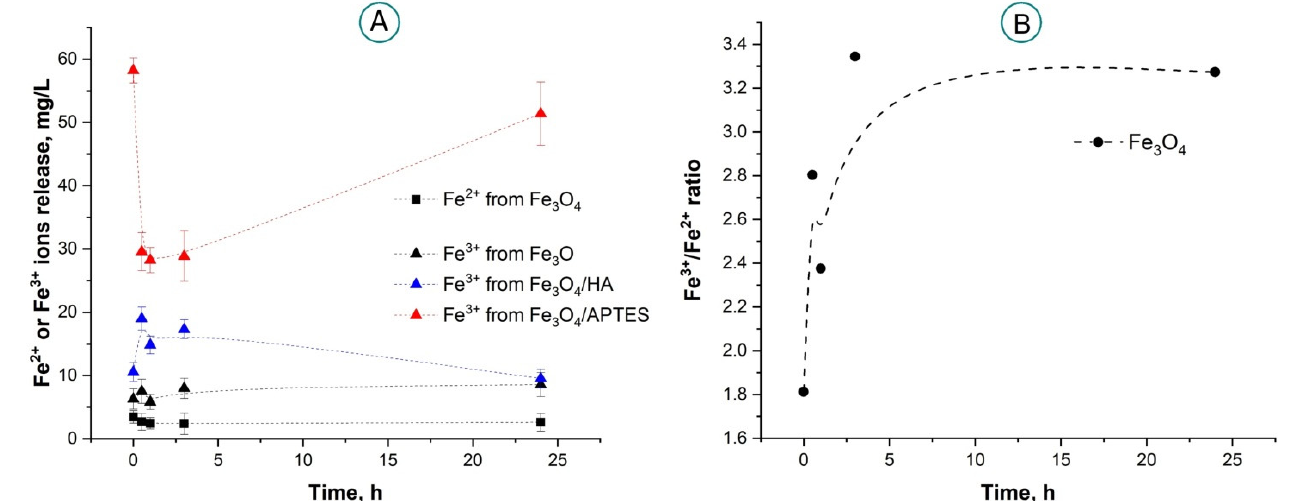
Figure 2. Kinetics of release of iron ions by MNPs ( A , B ) (mg/L of ions from 1 g/L of Fe in the sample). Colors denote various nanoparticles, “square” markers denote the release of Fe 2+ ions, and “triangle” markers denote Fe 3+ ions. According to the obtained data, samples of Fe 3 O 4 /HA and Fe 3 O 4 /APTES release only Fe 3+ ions, while Fe 3 O 4 releases both Fe 2+ and Fe 3+ ions ( A ), and their ratio increases within three hours reaching a plateau ( B ).